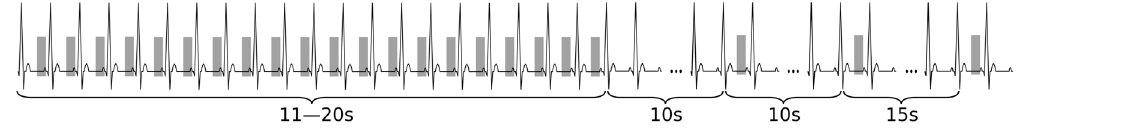
Fig. 2. Image acquisition protocol for 4D CT myocardial perfusion analysis. Image acquisition (gray area) is done in each RR-interval during the first 11– 20s . These 11– 20s are called dynamic phase. The length depends on the heart rate with the aim to cover up to 20 RR-intervals. Three additional single acquisitions (late phases) are done 10s , 20s , and 35s after the dynamic